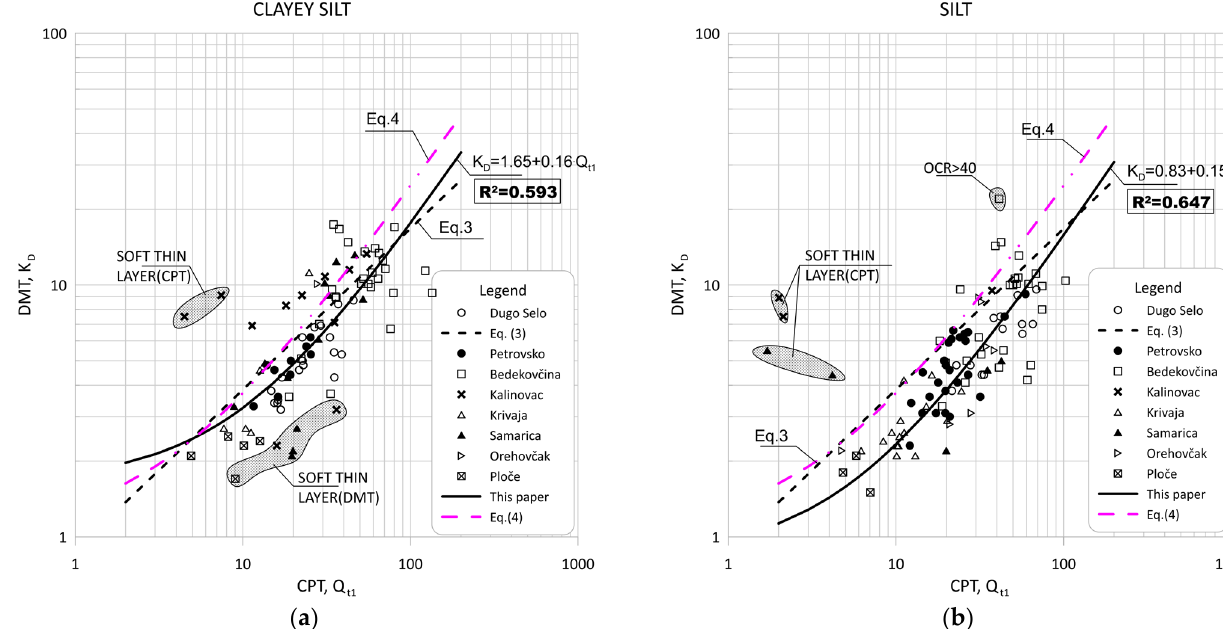
< 1.8, 2.05 < < 2.95). 𝐼𝐼 𝐷𝐷 𝐼𝐼 𝑐𝑐